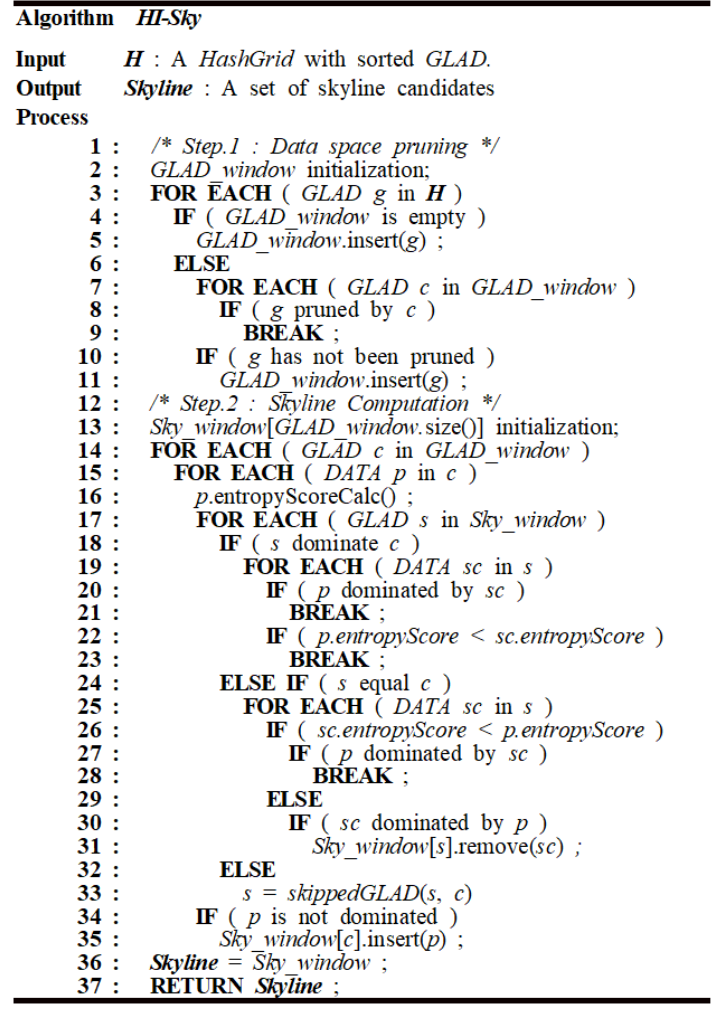
Figure 4. The pseudocode of the HI-Sky algorithm.